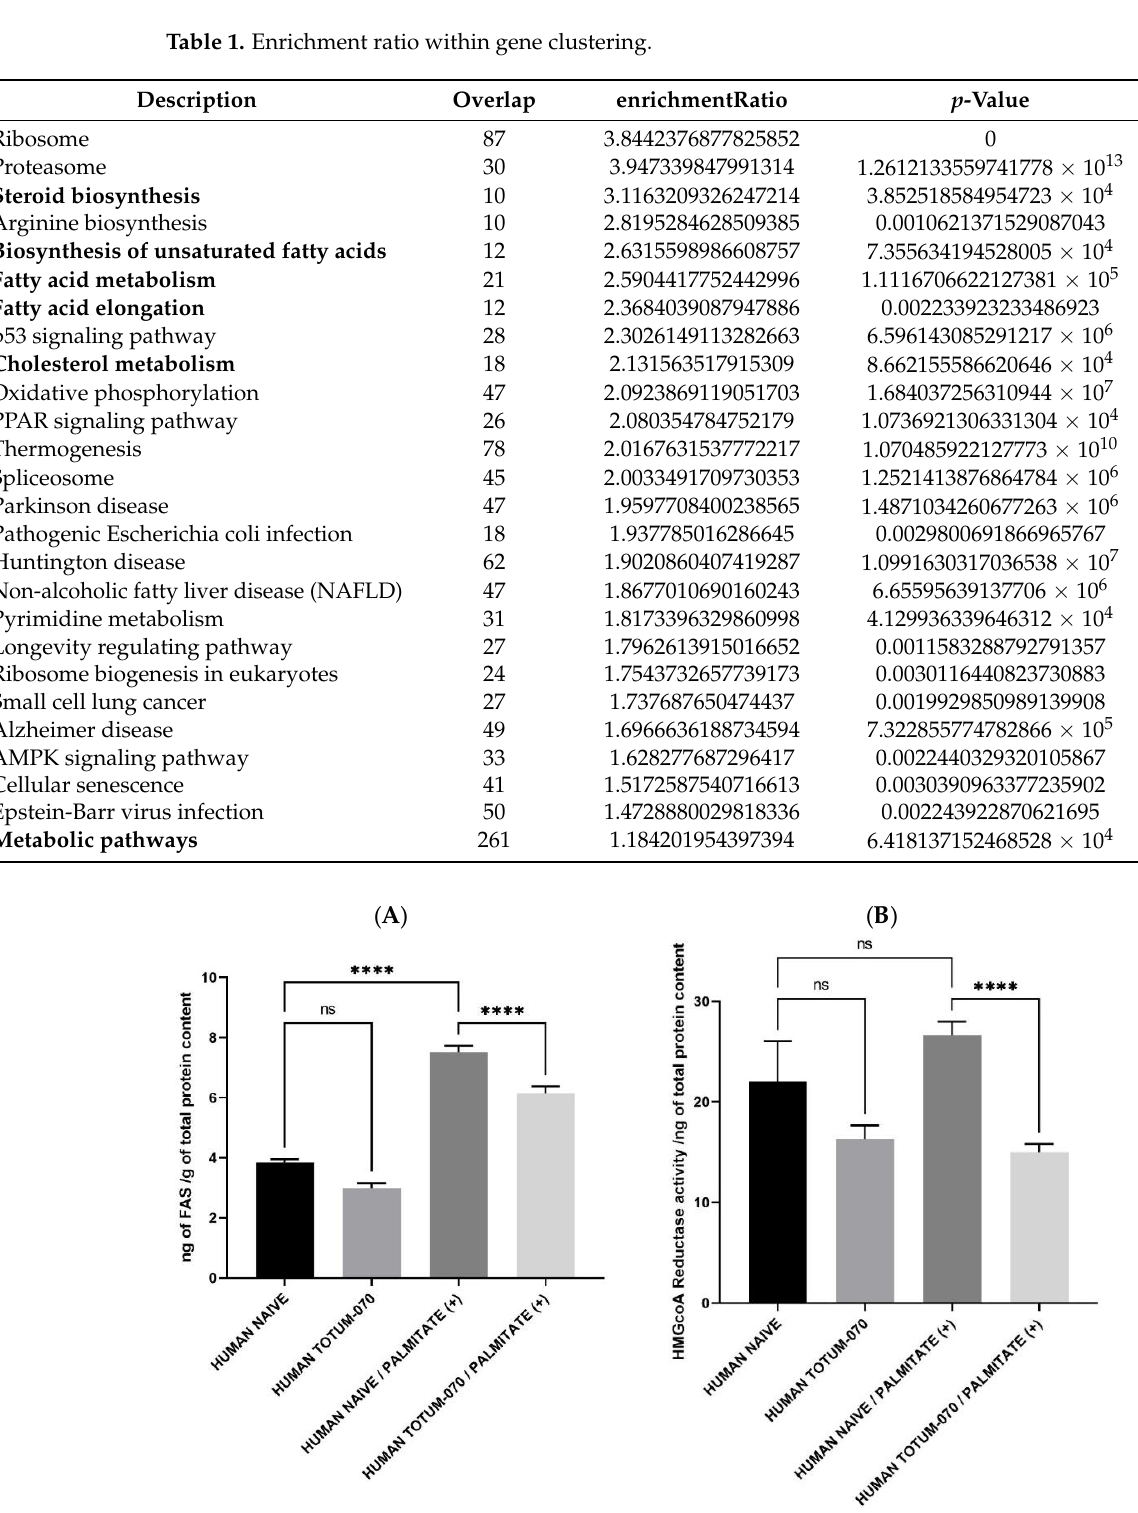
Figure 7. TOTUM-070 derived metabolites limit lipid synthesis. ( A ) Fatty acid synthase protein ex- pression. ( B ) HMG coA Reductase activity. Measures were performed in quadruplicates per